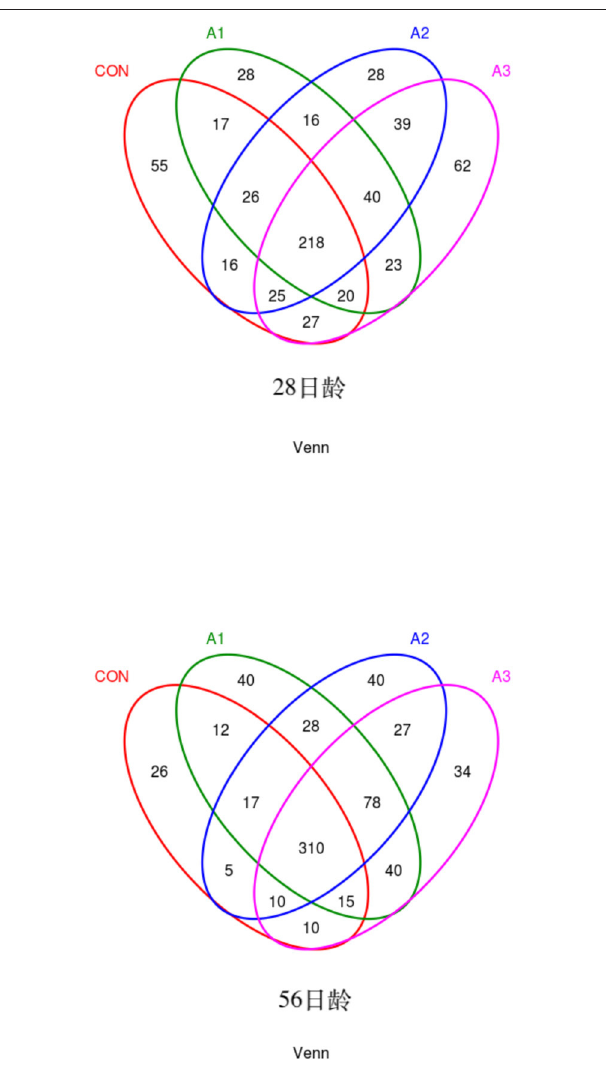
FIGURE 1 | Venn diagram illustrating overlap of microbial OTUs at 3% dissimilarity level among treatments. Venn diagram of bacteria at 28 days of age (left) or 56 days of age (right). CON, the dosage of B4 is 0mg / day; A1, the dosage of B4 is 15mg / day; A2, the dosage of B4 is 30mg / day; A3, the dosage of B4 is 45mg / day.